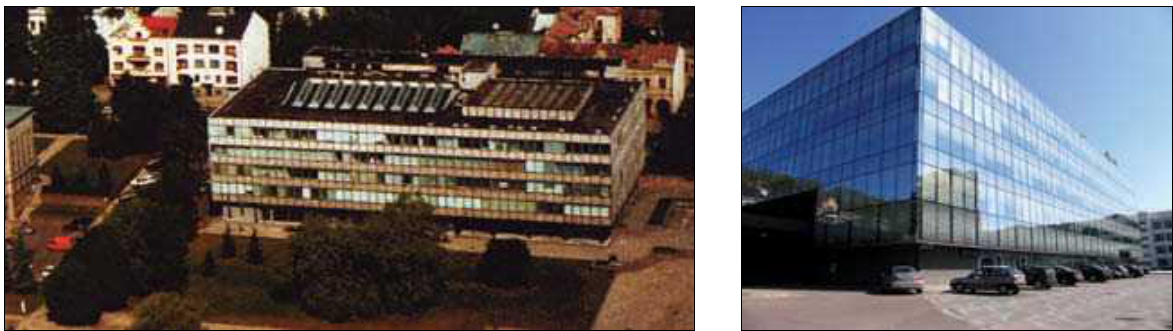
Figs. 11, 12. “Pramprojektas” in kau­nas (arch. a­. Sprindys) in 1972 and nowadays